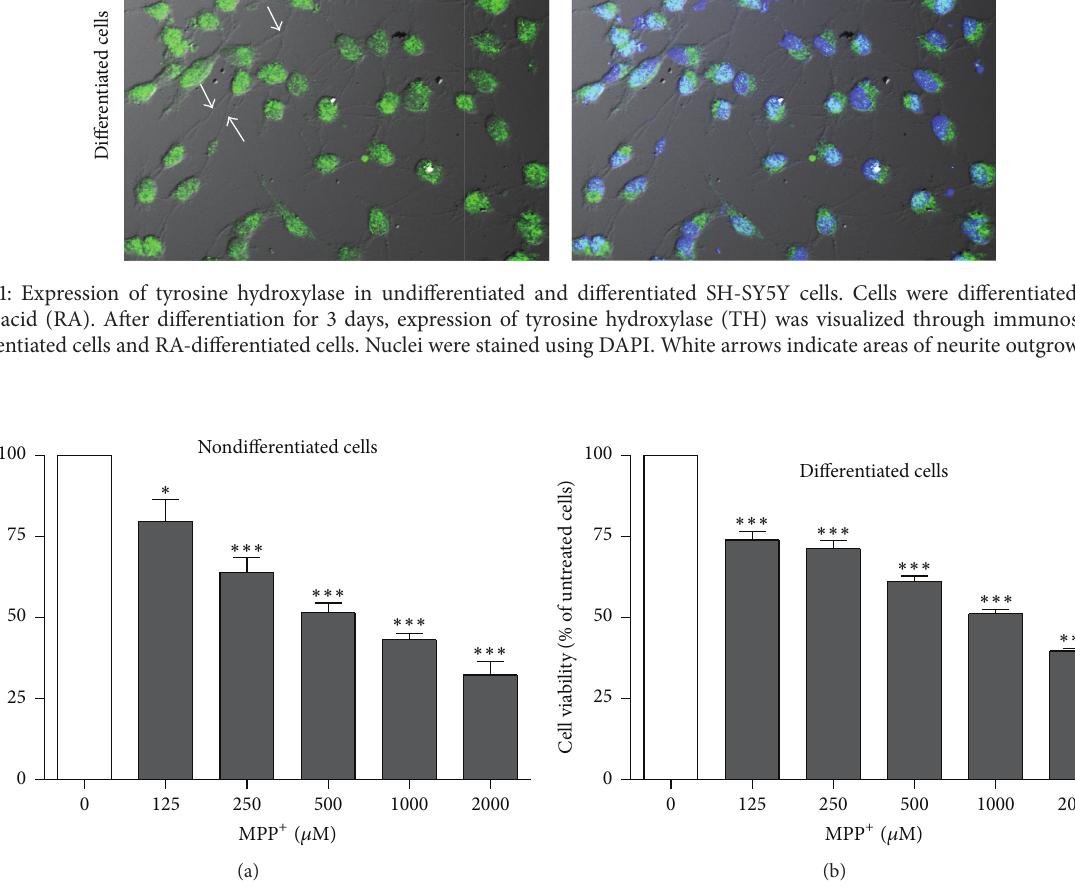
Figure 2: Effect of MPP + on cell viability of nondifferentiated SH-SY5Y cells (a) and effect of MPP + on cell viability of differentiated SH-SY5Y cells (b). Cells were exposed to 125, 250, 500, 1000, and 2000 𝜇 M of MPP + for 24 hours and cell viability was measured with an MTT assay. For neuronal differentiation, SH-SY5Y cells were treated with 10 𝜇 M retinoic acid for three days before exposure to MPP + . The control groups for nondifferentiated and differentiated SH-SY5Y cells were treated with the same medium without MPP + . MTT assays were repeated three times in triplicate measurement. Data are shown as mean ± SEM. ∗ indicates 𝑃 < 0.05 and ∗ ∗ ∗ indicates 𝑃 < 0.001 versus 0 𝜇 m of MPP +